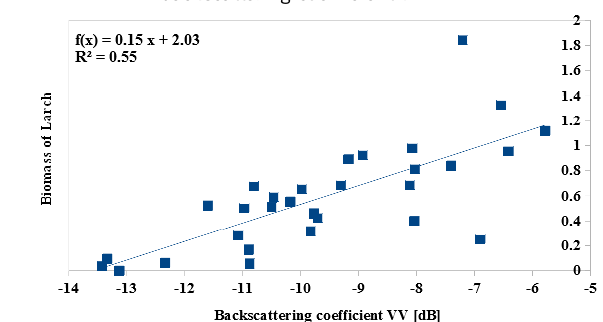
Figure 2. The relationship between the Larch biomass and the backscattering coefficient VH